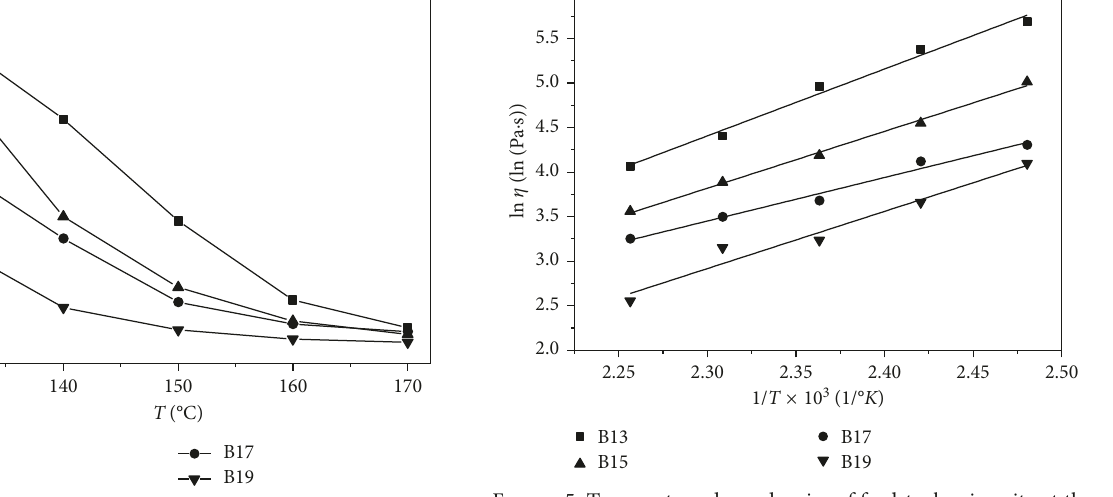
Figure 4: Temperature dependence of the yield stress of feedstocks with different binder contents.